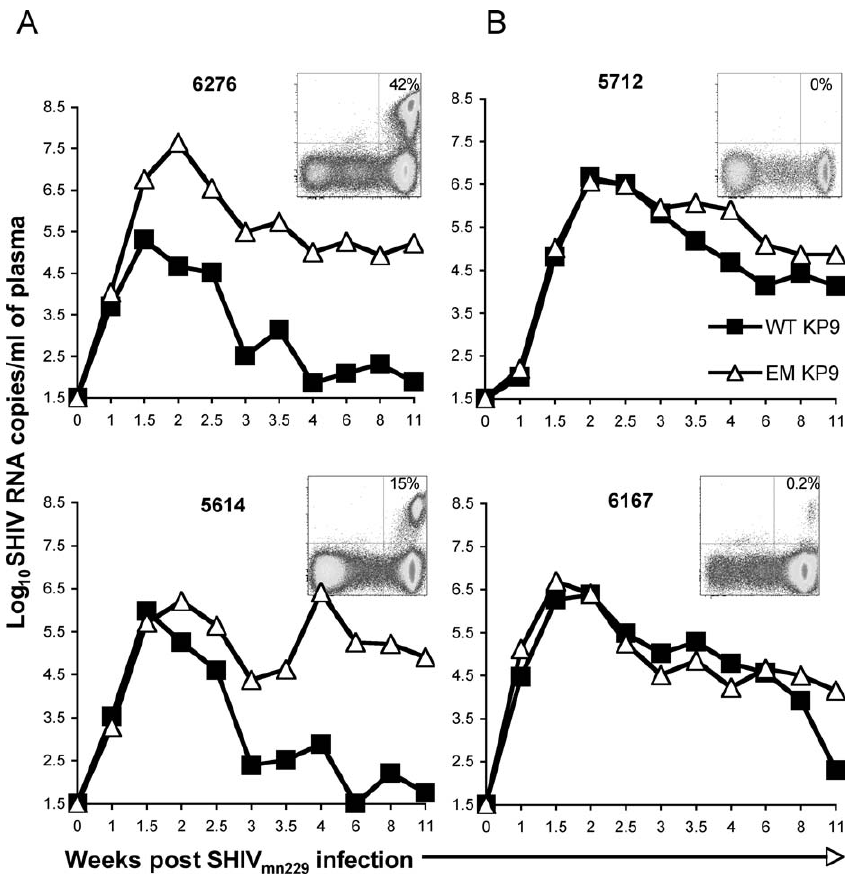
Figure 5. Transient Reversions and Re-Escape Timing Is Influenced by Prior Vaccination and Levels of KP9-Specific CTL Wild-type (closed squares) and escape mutant (open triangles) KP9 was measured by SIV Gag KP9 qRT-PCR to compare the kinetics of transient reversion and re-escape in four Mane-A*10 þ pigtail macaques; 6276 and 5614 were vaccinated with DNA/FPV prime/boost vaccines (A), 5712 and 6167 were the control animals and had no prior induction of KP9-specific T cells (B). Levels of KP9-specific CD8 T cells detected by the Mane-A*10/KP9 tetramer at 2 weeks after challenge for each animal are shown as an inset. The y -axis is the KP9 tetramer and the x -axis is CD8. Cells shown are gated CD3 þ lymphocytes.